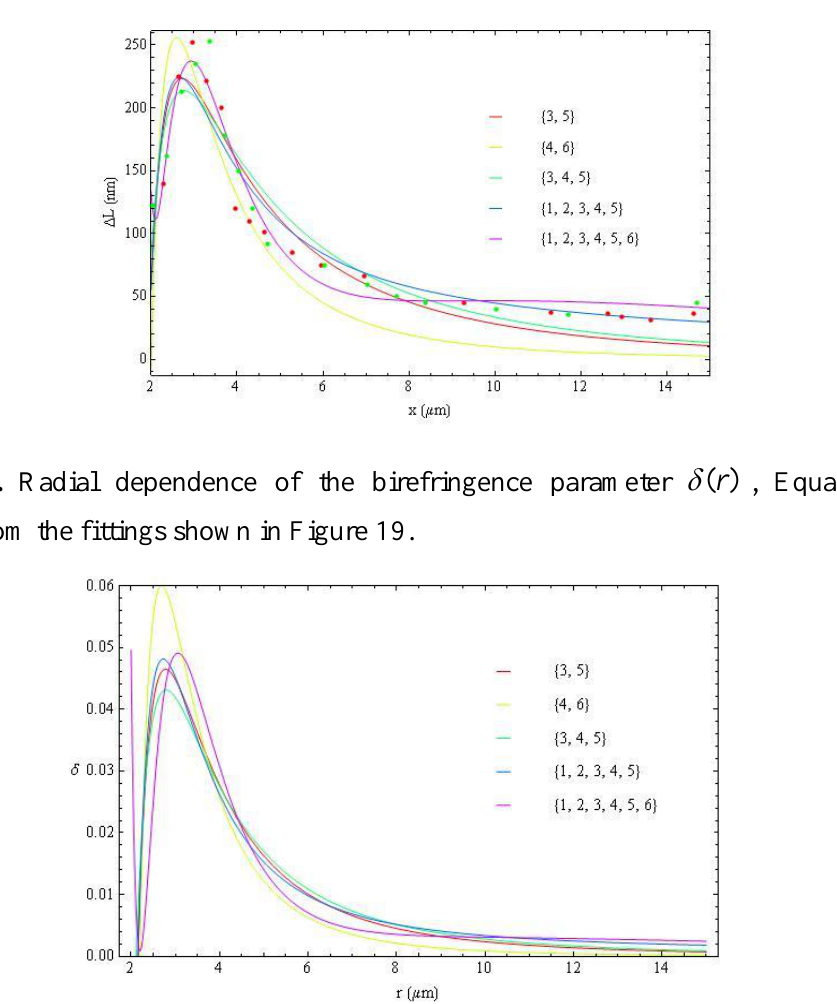
Figure 19. Fitting (all) experimental data with Equation (20) with different sets of m , shown in the legend.